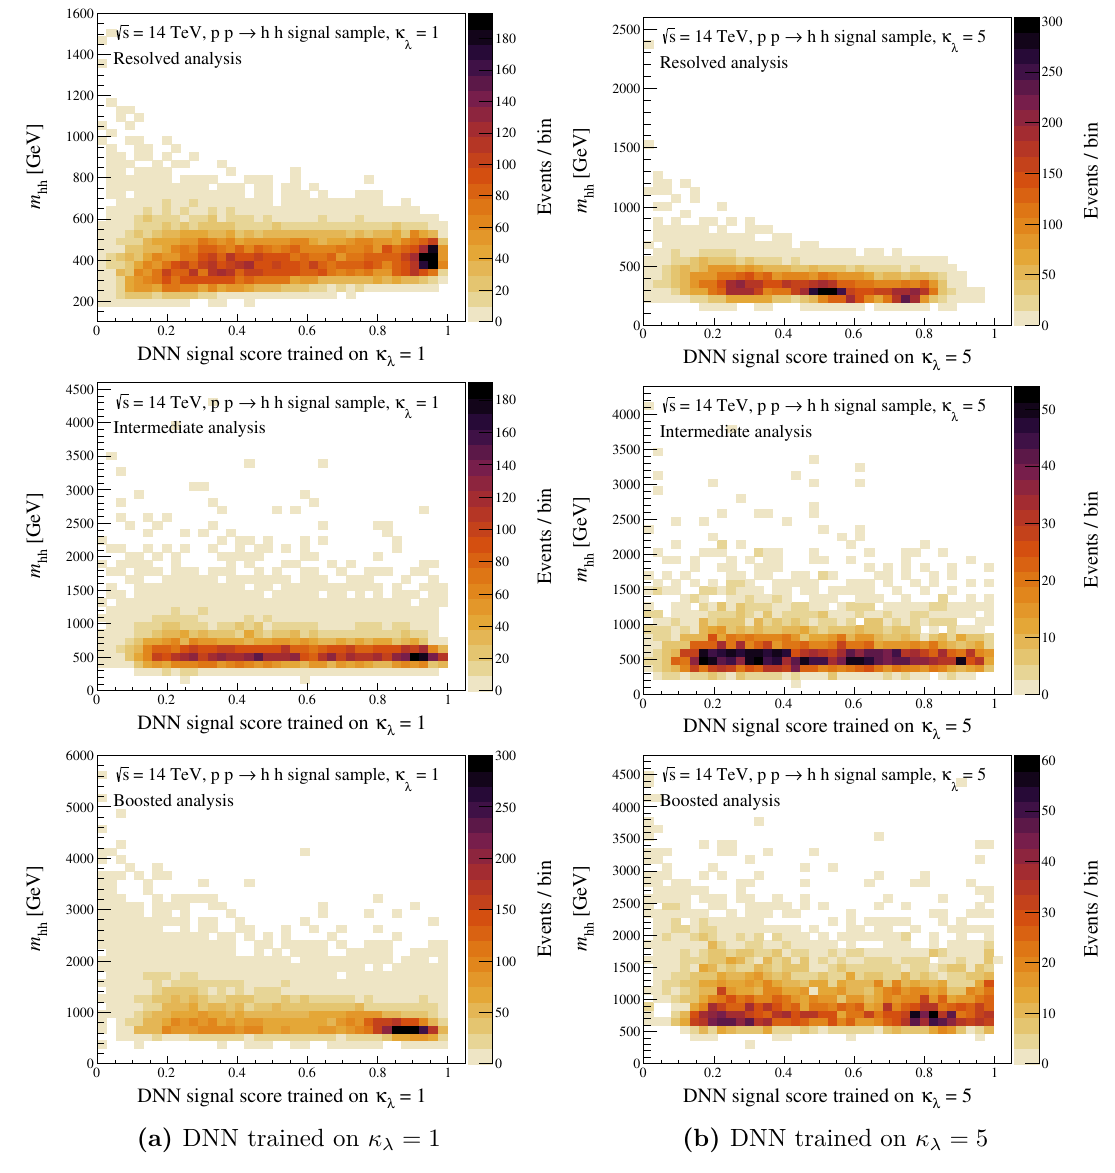
Figure 24. The di-Higgs invariant mass m hh vs neural network scores trained on (a) κ λ = 1 and (b) κ λ = 5 signal sample for the (upper) resolved, (middle) intermediate, and (lower) boosted analyses. The test samples used to make these distributions are an independent set of (a) κ λ = 1 and (b) κ λ = 5 signal